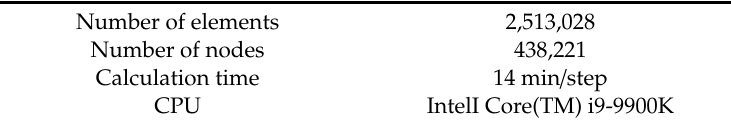
Figure 12. Magnetic characteristics of the magnetic material. ( a ) Yoke; ( b ) Permanent magnet.